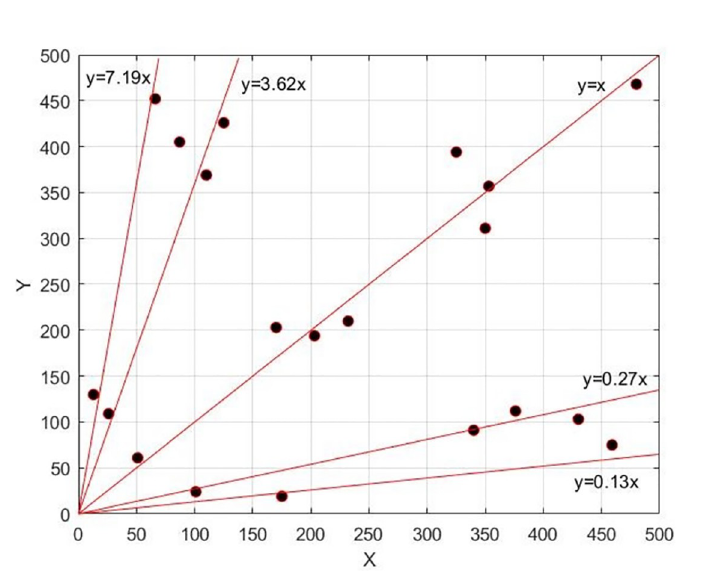
Fig 4. Scatter diagram of aspect ratio of